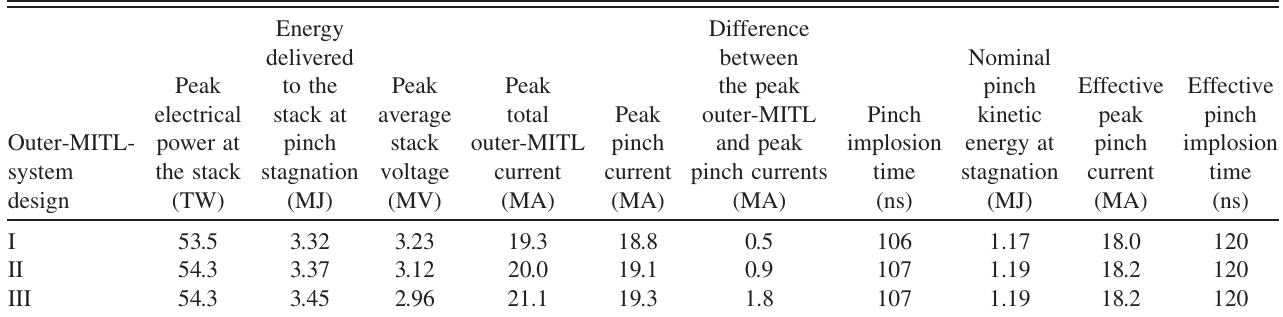
TABLE V. Results of TL simulations for MITL designs I, II, and III. Nominal geometric impedances of the four outer MITLs for each design are listed in Table IV. The simulations assume a z -pinch load with a 2-cm length, 2-cm initial radius, and 4.27-mg total mass, which was the Z accelerator’s baseline load. The effective peak pinch current and effective pinch implosion time are defined in Appendix